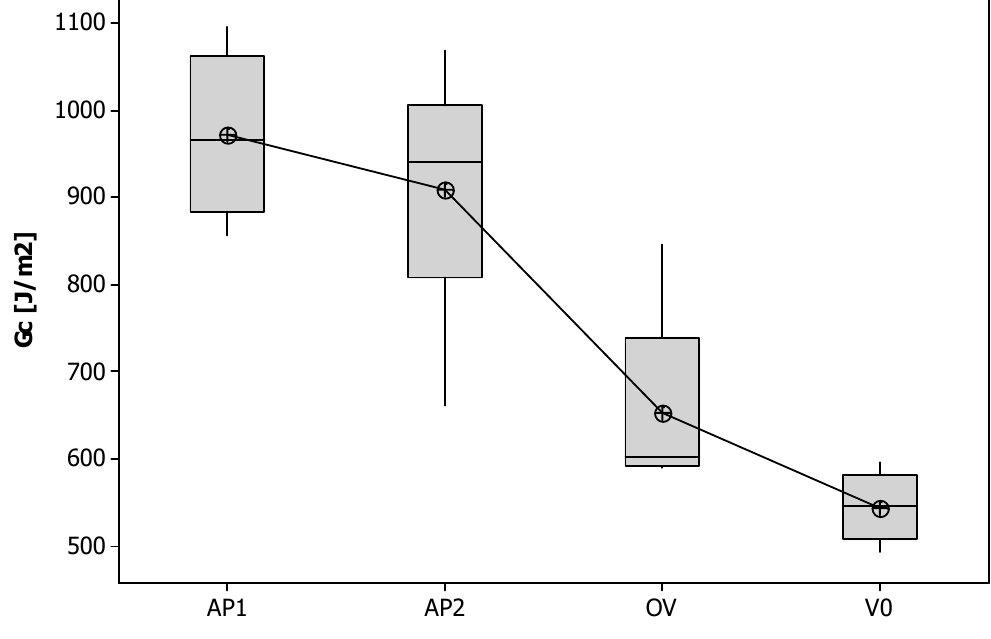
Figure 8. G IC values for the laminates modified with insoluble veils.